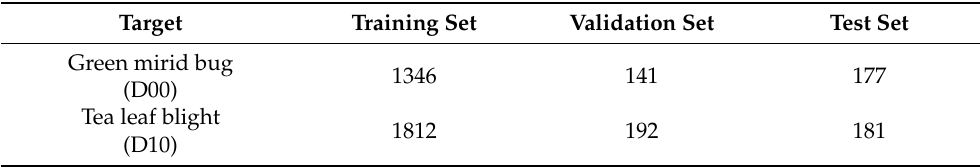
Table 1. Target numbers in tea